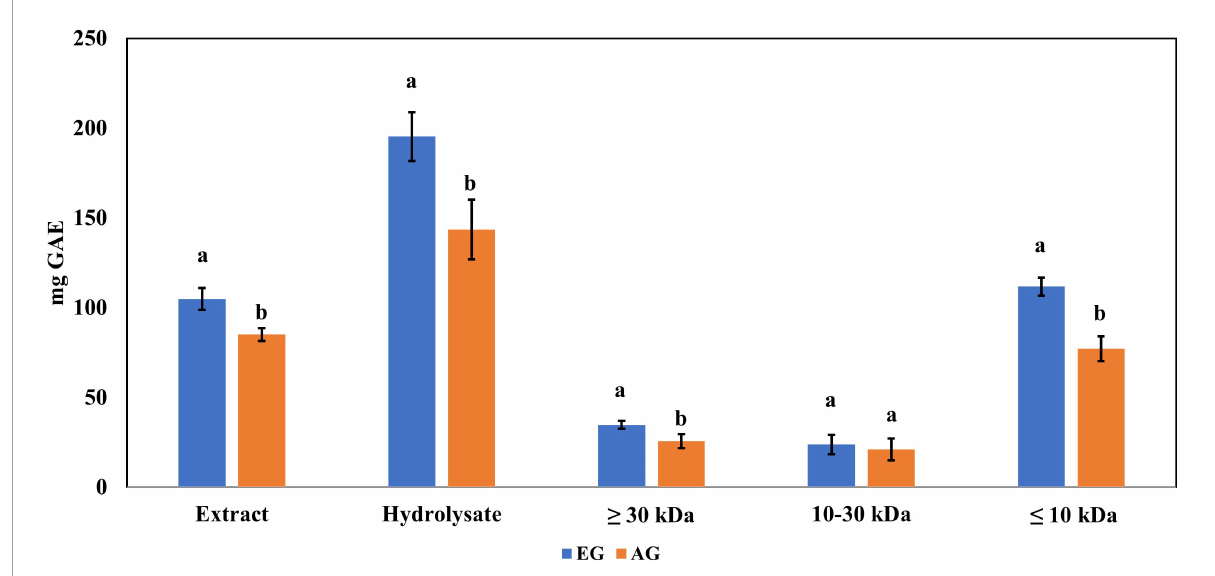
FIGURE1 Total phenolic content in extracts, hydrolysates, and hydrolyzed fractions of early grasshopper (EG) and adult grasshopper (AG). Results obtained are reported in milligrams of gallic acid equivalents (mg GAE)/gram dry weight. Different letters between bars indicate significant difference ( p -value <